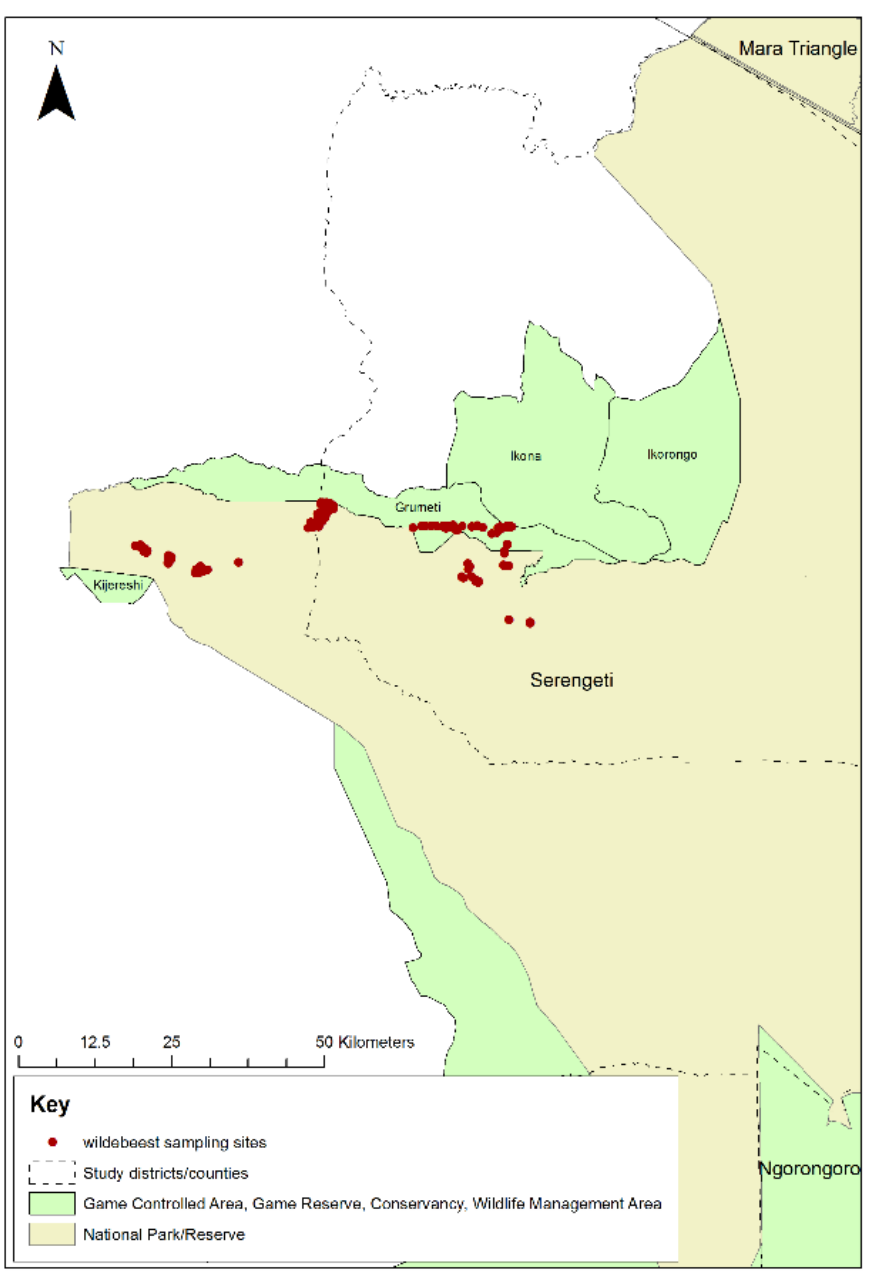
Figure 3. Map of Serengeti National Park showing locations where wildebeest faecal samples were collected in western Serengeti National Park and Grumeti Game Reserve, 2018.